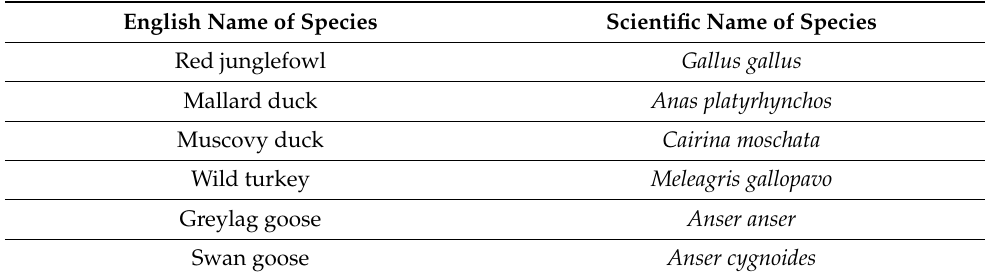
Table 1. Common poultry species included in this critical